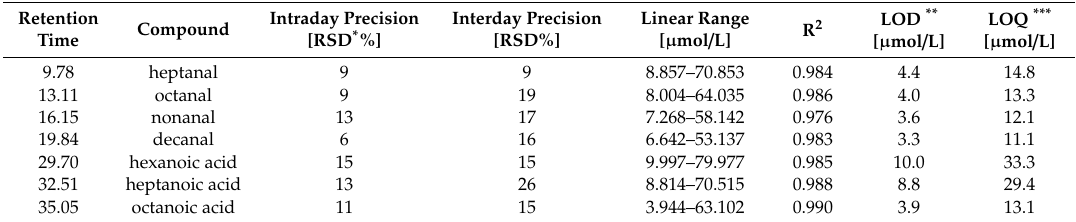
Table 2. Validation parameters calculated for a mixture of commercial standards. Compounds are ordered with respect to their increasing retention